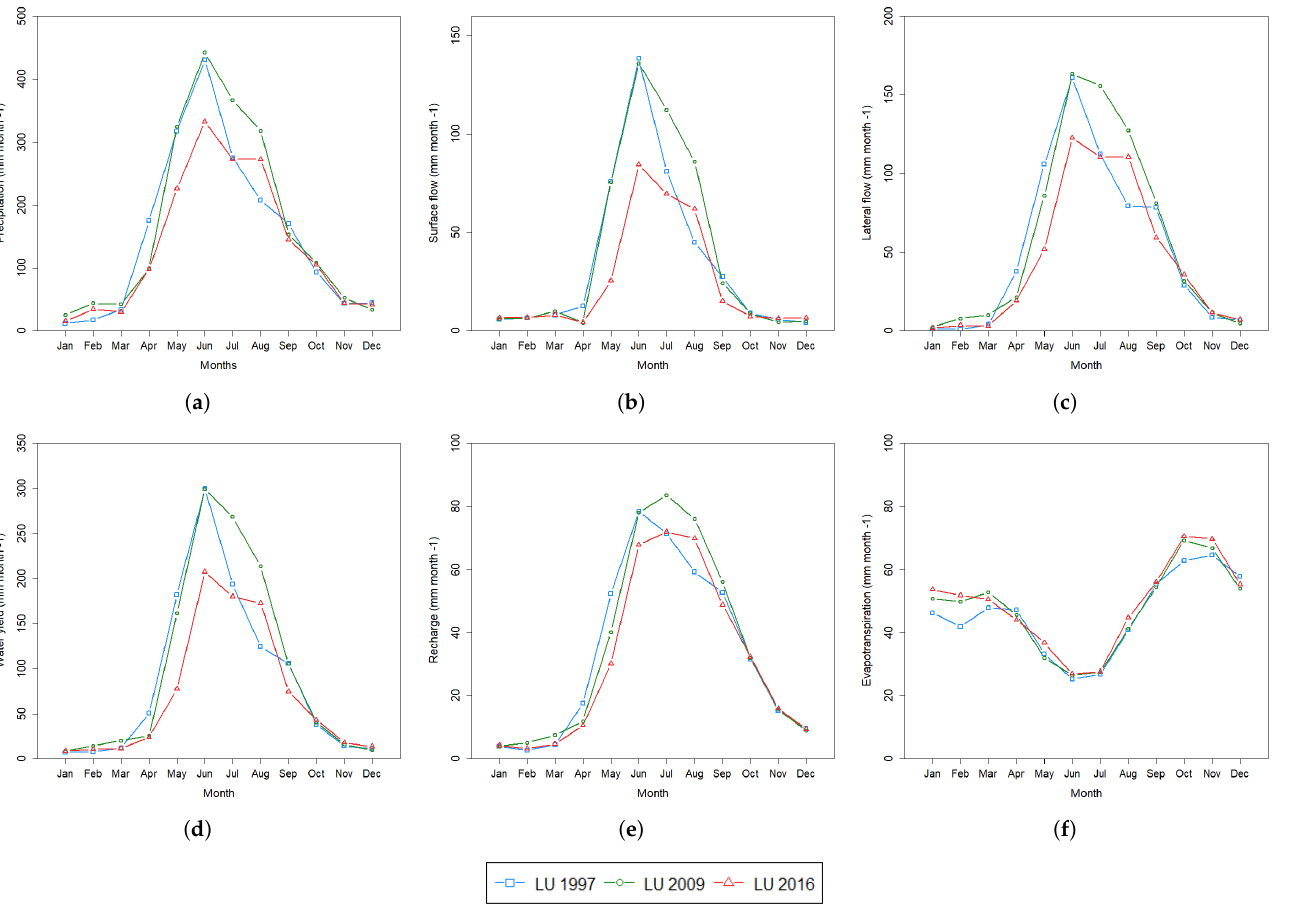
Figure 5. Monthly average values for the studied periods with LU 1997 (1990–1999), LU 2009 (2000–2009), and LU 2016 (2010–2019) for the parameters: ( a ) Precipitation, ( b ) Surface flow,